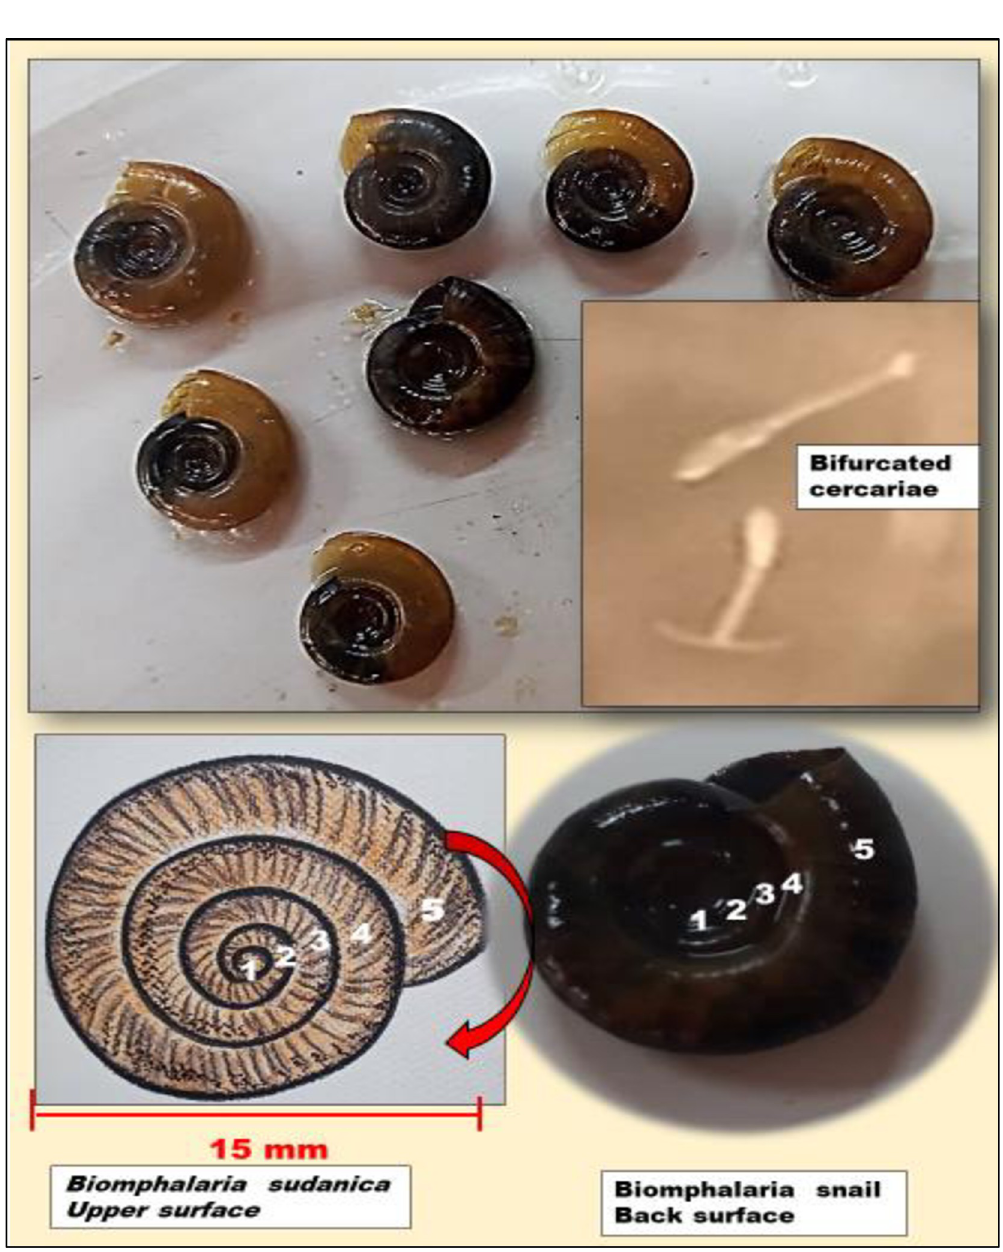
Fig 2. Sampled snails of Biomphalaria sudanica species. Notice the number of shell coils (5) which differentiate B . sudanica from other species. Biomphalaria is right coiled (clockwise coil). Shedded bifurcated cercariae are also visible in the picture. The bifurcated cercariae indicate human schistosoma